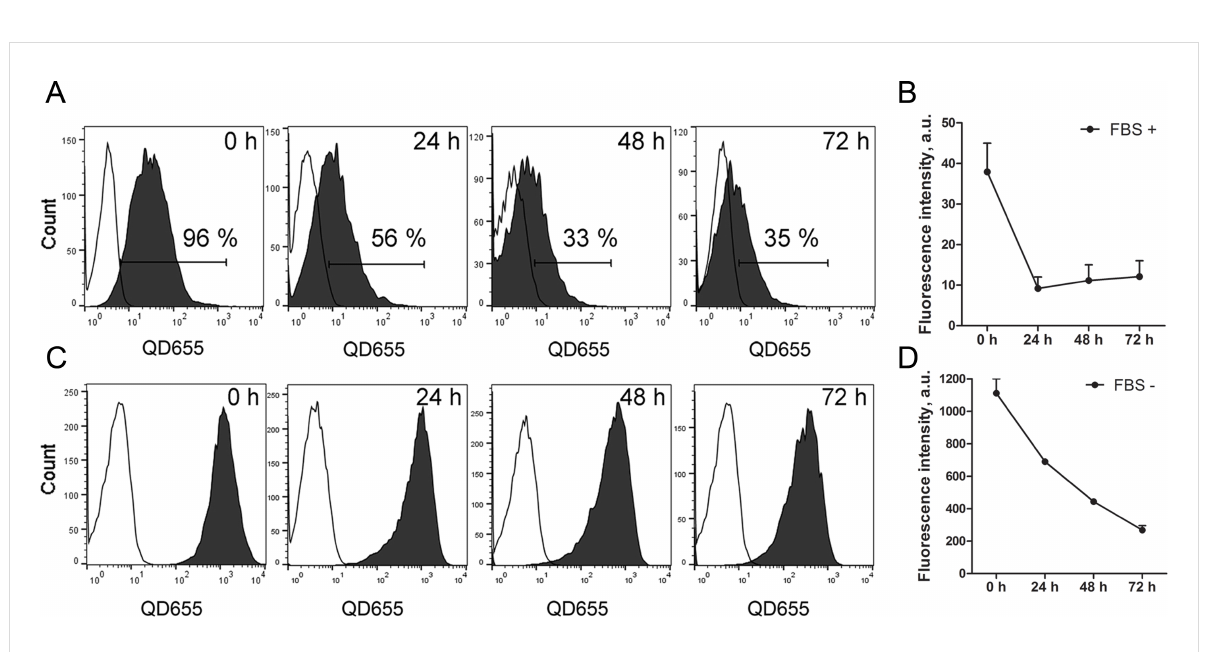
Figure 3: The dynamics of quantum dot (QD) signal in mesenchymal stem cells (MSCs) 3D culture. Representative data of MSC QD signal analysis in 3D culture after labelling in complete (A) or serum-free medium (C). The changes of the QD fluorescence signal intensity in the 3D MSC population after labelling in complete (B) and in serum-free (D)